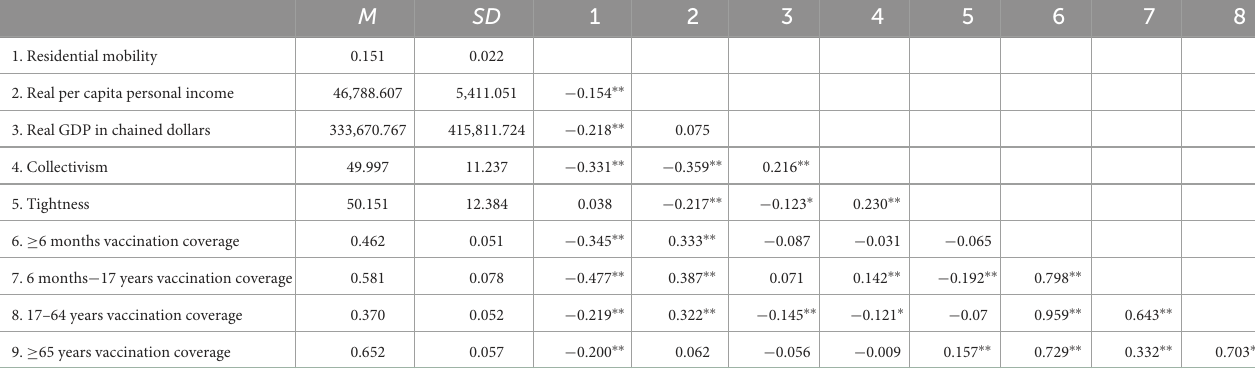
TABLE 5 Descriptive statistics of main variables of study 3.